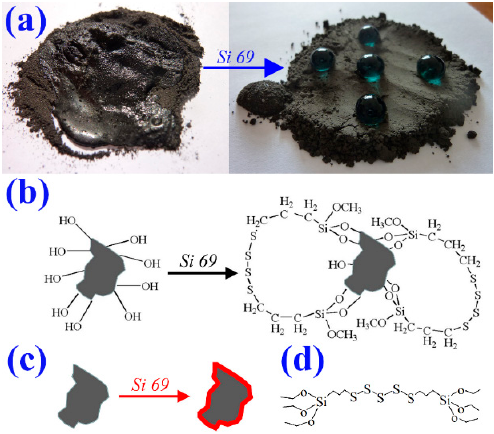
Figure 2. The particle size distribution of the obtained foundry dust (FD) powders. The inset shows the FE-SEM image of the FD powder.